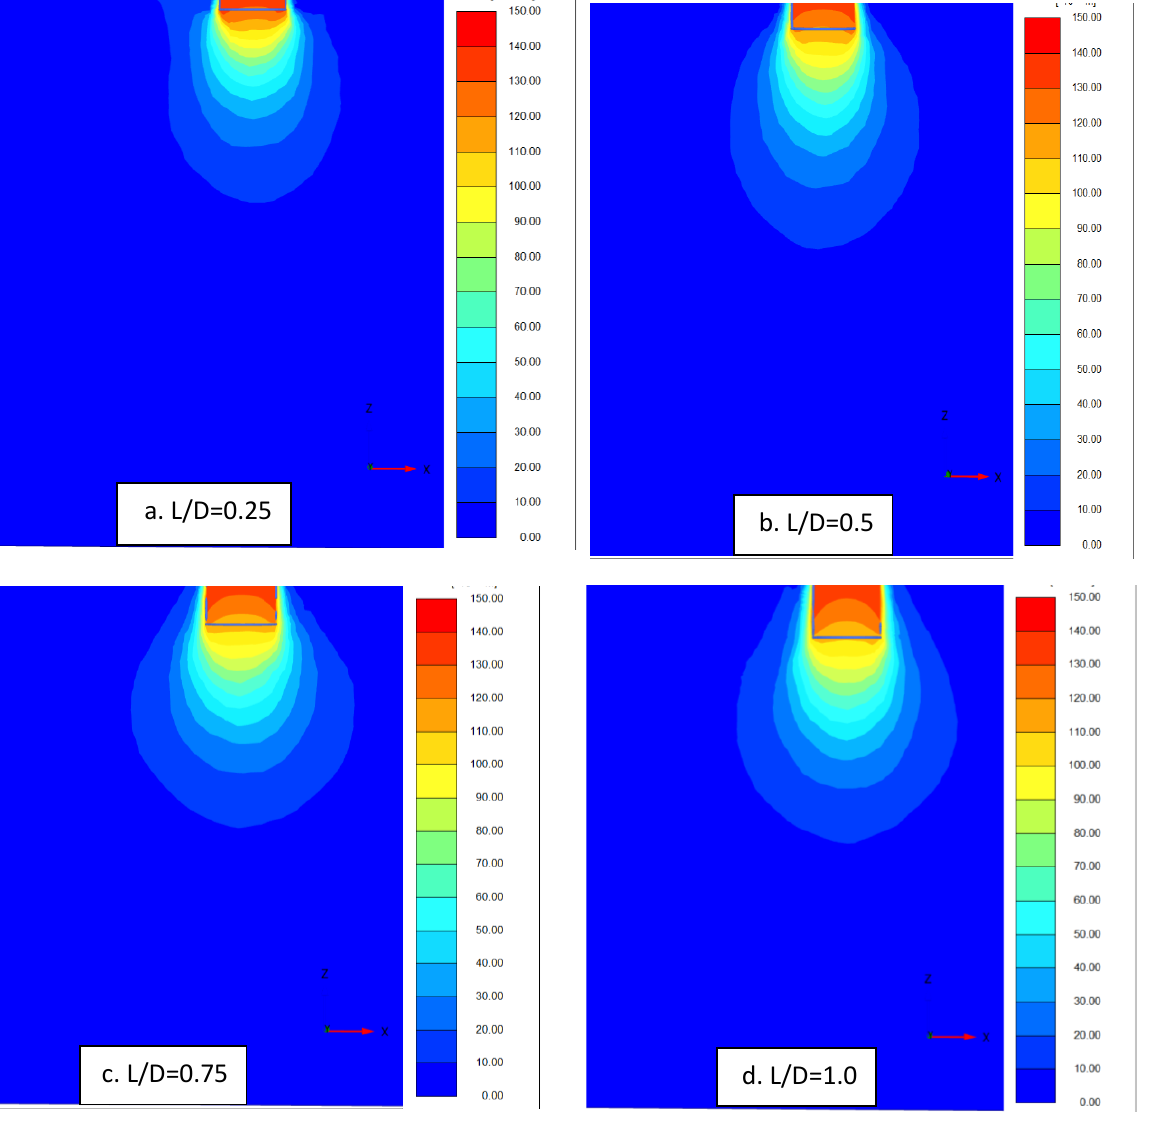
Fig. 8. Shading view result in